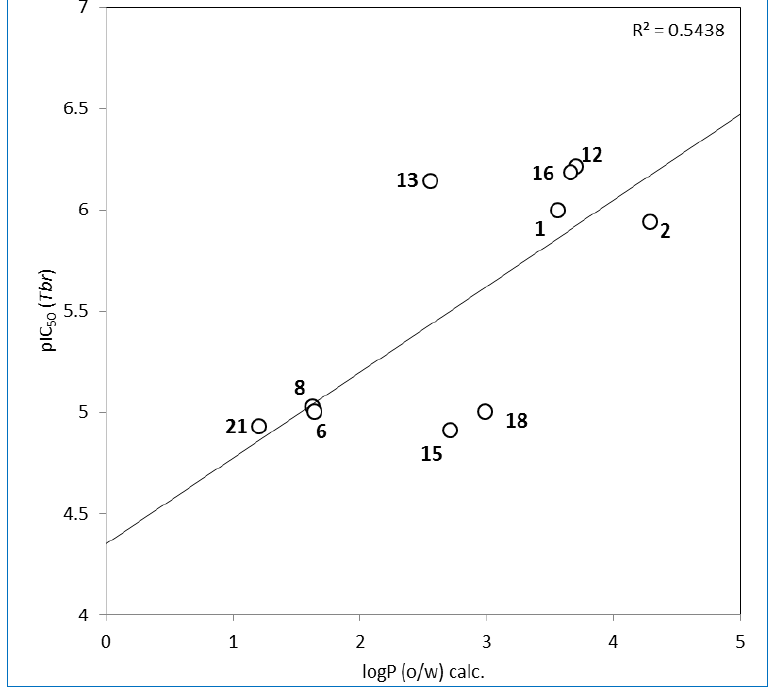
Figure 3. Plot of anti-trypanosomal activity as pIC 50 [=−log (IC 50 )] versus calculated octanol/water partition coefficient data of compounds 1 , 2 , 6 , 8 , 12 , 13 , 15 , 16 , 18 and 21